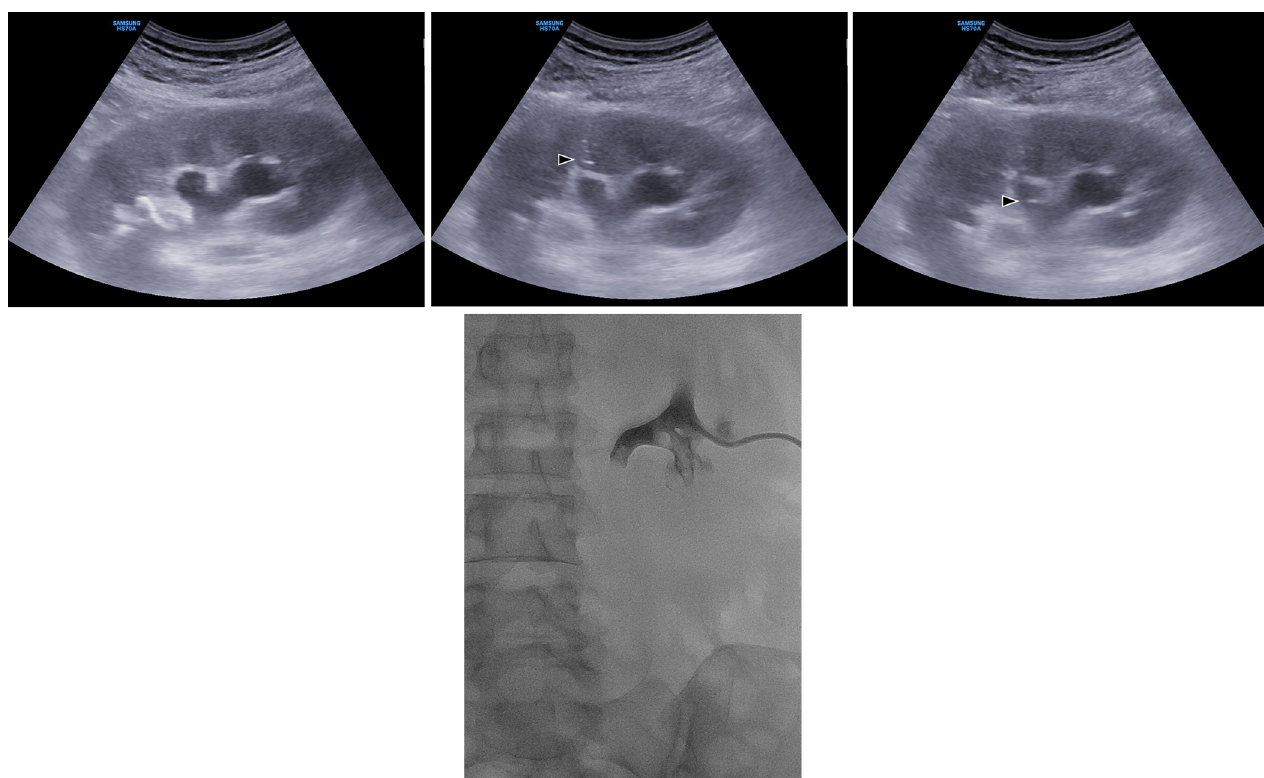
Fig 1. Renal access for dilated renal calyx with hydronephrosis under ultrasound guidance. (A) A grayscale ultrasonography image showed a dilated middle and superior renal calyces and replaced inferior renal calyx with renal stone in the right kidney. (B) A 21-G Chiba needle (arrowhead) was advanced to the center of the renal pyramid at middle pole. (C)The Chiba needle (arrowhead) was introduced into the dilated renal calyx. (D) Finally an 8.5Fr drainage catheter was successfully inserted after renal access via dilated renal calyx.